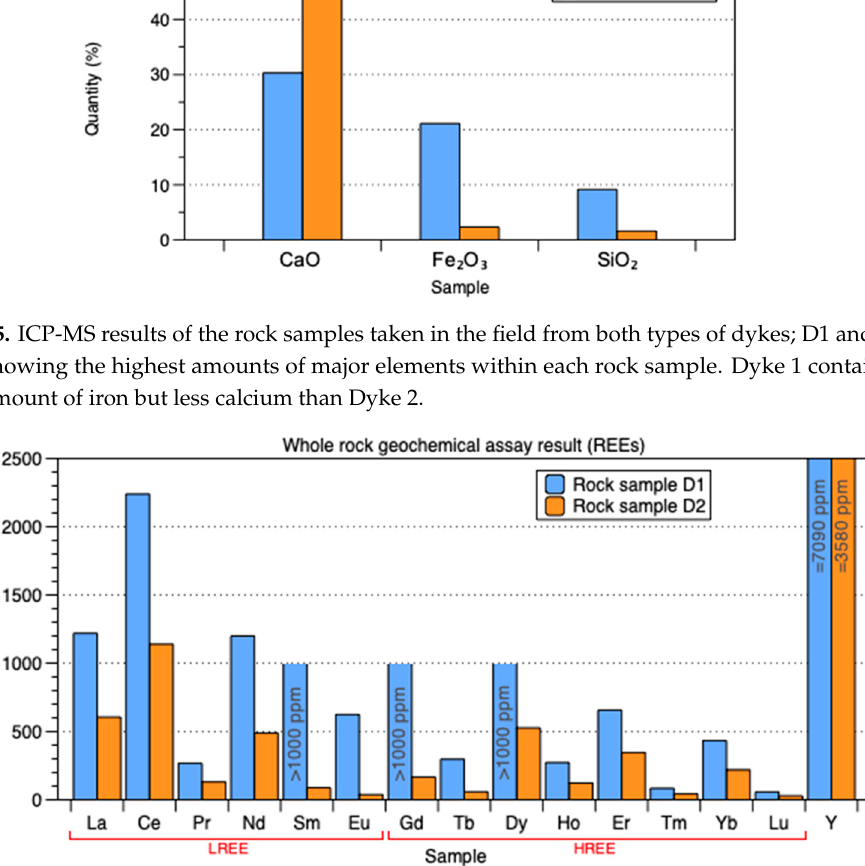
Figure 16. ICP-MS results of the rock samples taken in the field from both types of dykes; D1 and D2. Graph showing the amount of REEs within each rock sample. Dyke 1 has a higher concentration of REEs than Dyke 2.